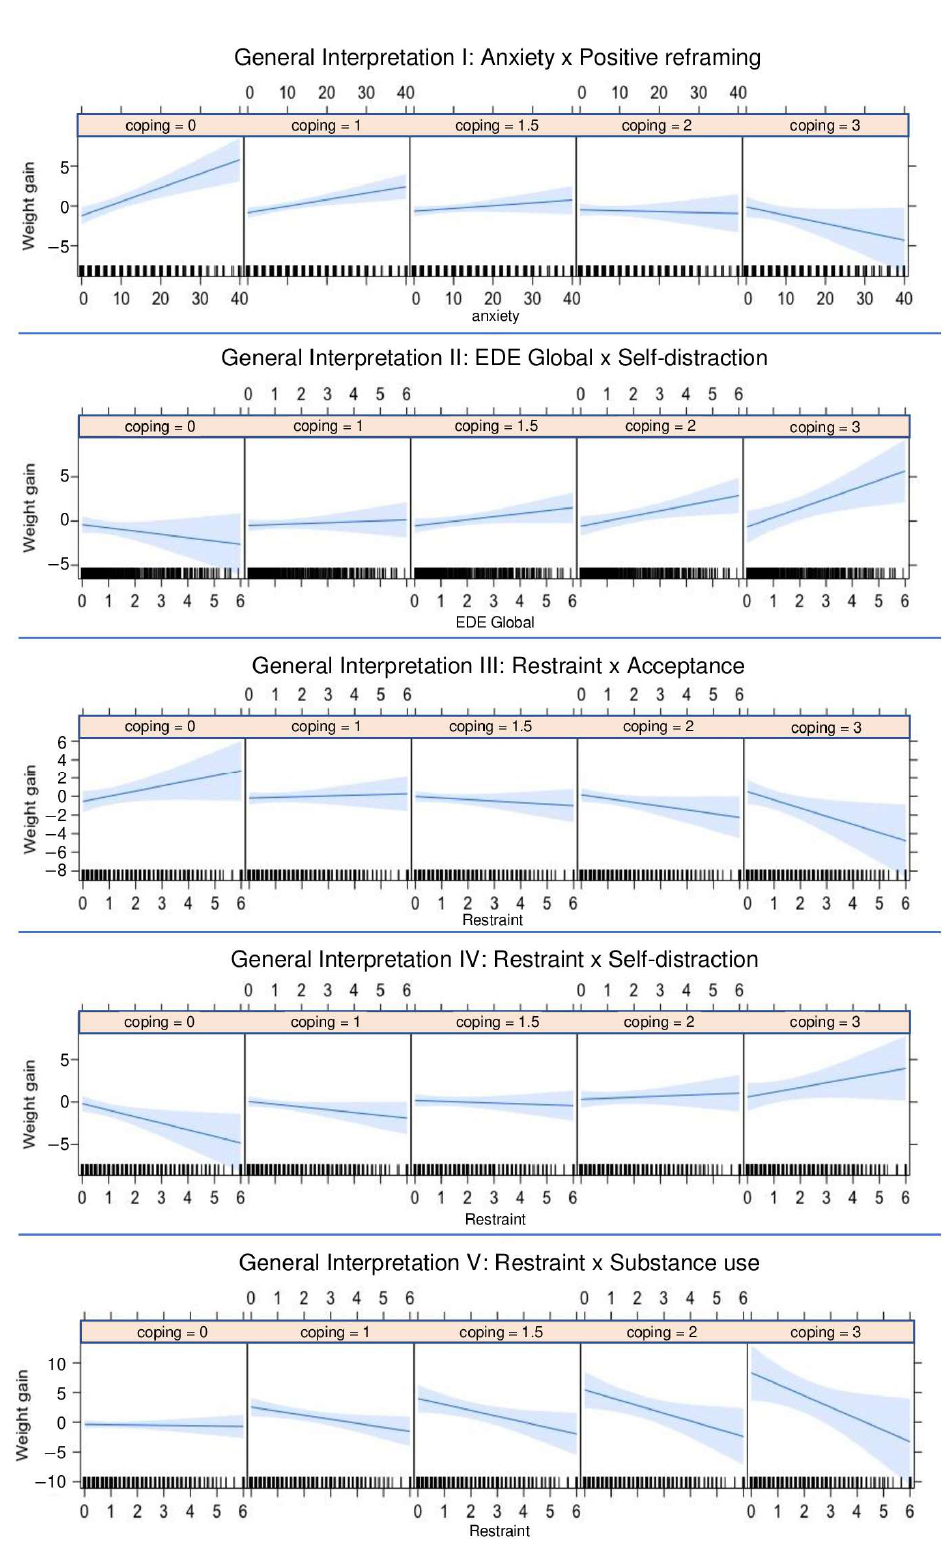
Figure 2. The moderator effects of coping strategies in relation to weight